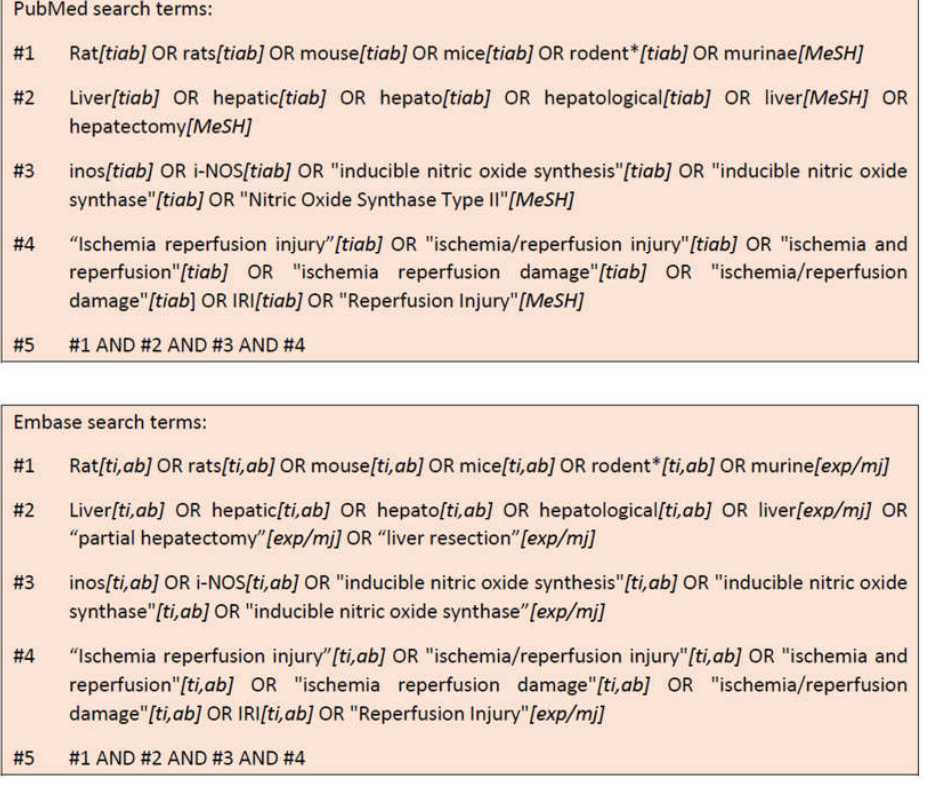
Figure 14. Search terms and their combination used for PubMed and Embase.